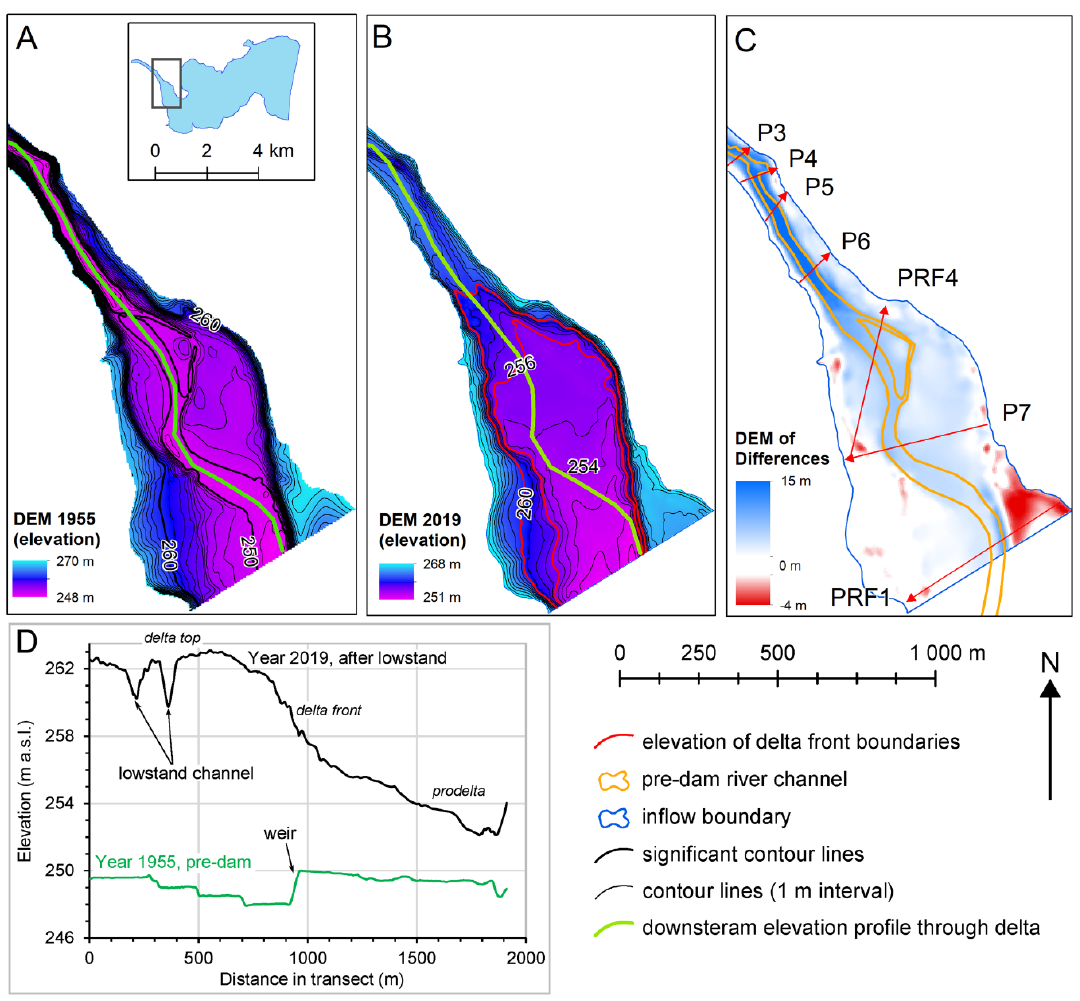
Figure 7. Map of elevation differences in the Nechranice inflow. ( A ) Pre-dam topography, ( B ) current topography from sonar imaging, ( C ) reservoir sediment thickness as an elevation difference of digital elevation models (DEMs) in panels A and B, ( D ) elevation change in the inflow delta along the pre-dam thalweg (green line in panels B and C) with an assignment of delta morphological features.